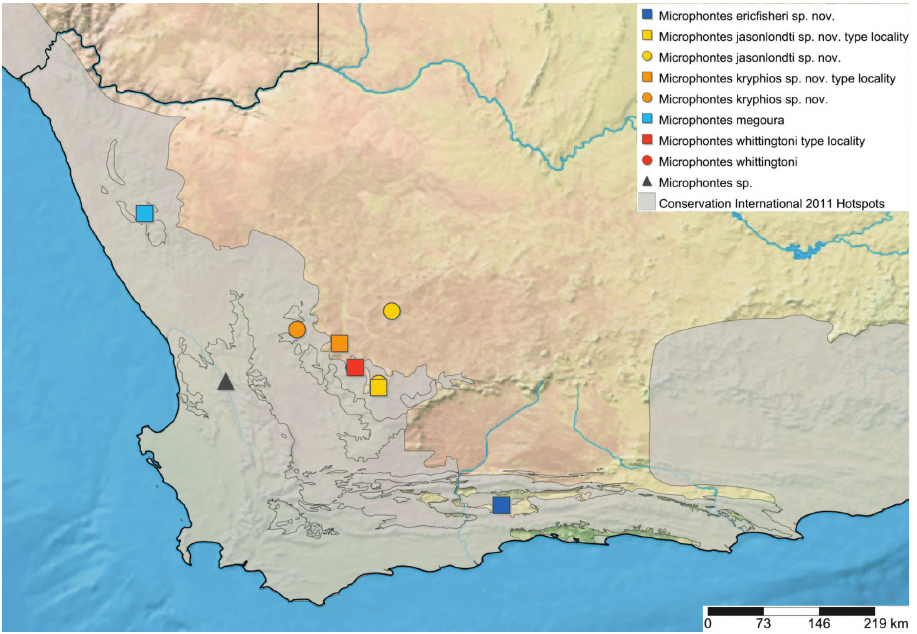
Figure 71. Map of south-western South Africa with elevational relief, Biodiversity Hotspots ( sensu Con- servation International) and distribution of Microphontes species occurring in South Africa (SimpleMappr 10598). Map data available in Google Earth KML file 10598 and also through GBIF (data-set http://www. gbif.org/dataset/4c13483d-a2ac-4c61-9087-c4e1a3c7b91d, DOI